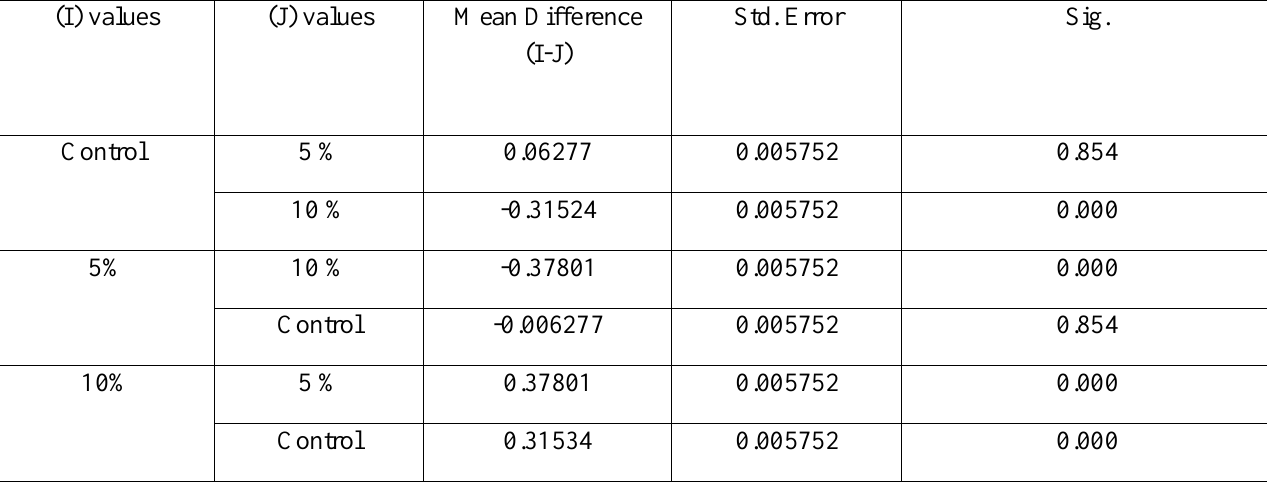
Table 11: Post HOC test between groups of water solubility test (mg/cm 2